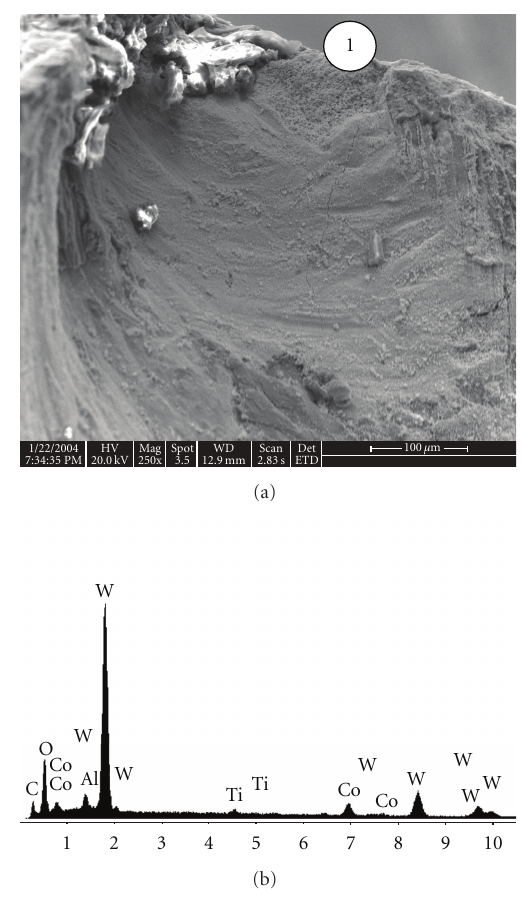
Figure 12: (a) SEM image of the coloured zone close to the sharp end of a drilling tool after working 35 holes at 20 m/min. (b) EDS analysis in the point marked as 3 in Figure 8(b) and in the one marked as 1 in Figure